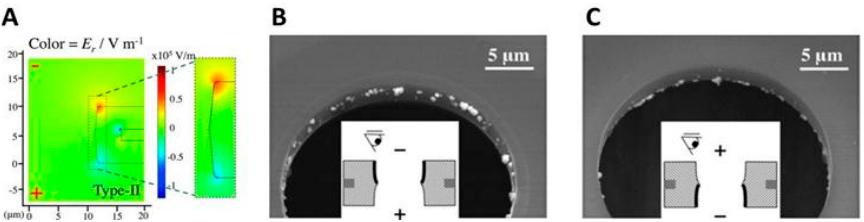
Figure 5. Correlation between numerical simulation and experimental data when analyzing the influence of the pore geometry. ( A ) Numerical simulation (radial electrical field, E r ) showing the polarization of one side of the pore membrane. ( B , C ) The side of gold deposition could be controlled experimentally by achieving ( B ) electro-oxidation or ( C ) electro-reduction.